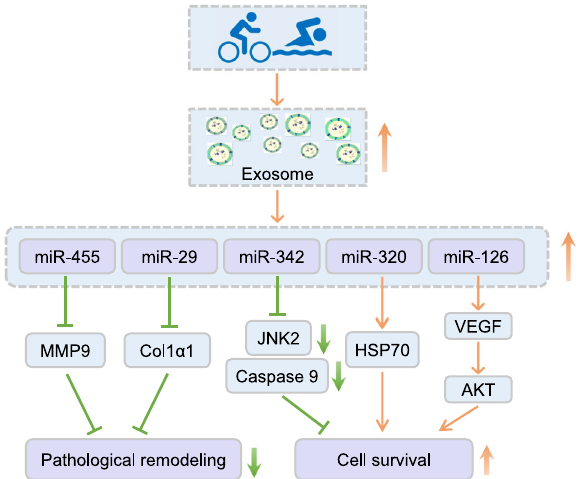
Fig. 4 Exosomal-miRNAs identi fi ed from exercised hearts. Exercise promotes EVs and exosomal-miRNAs secretion. This fi gure shows the mechanism of exosomal-miR-455, miR-29, miR-342, miR-320, and miR-126 in exercise-induced cardiac